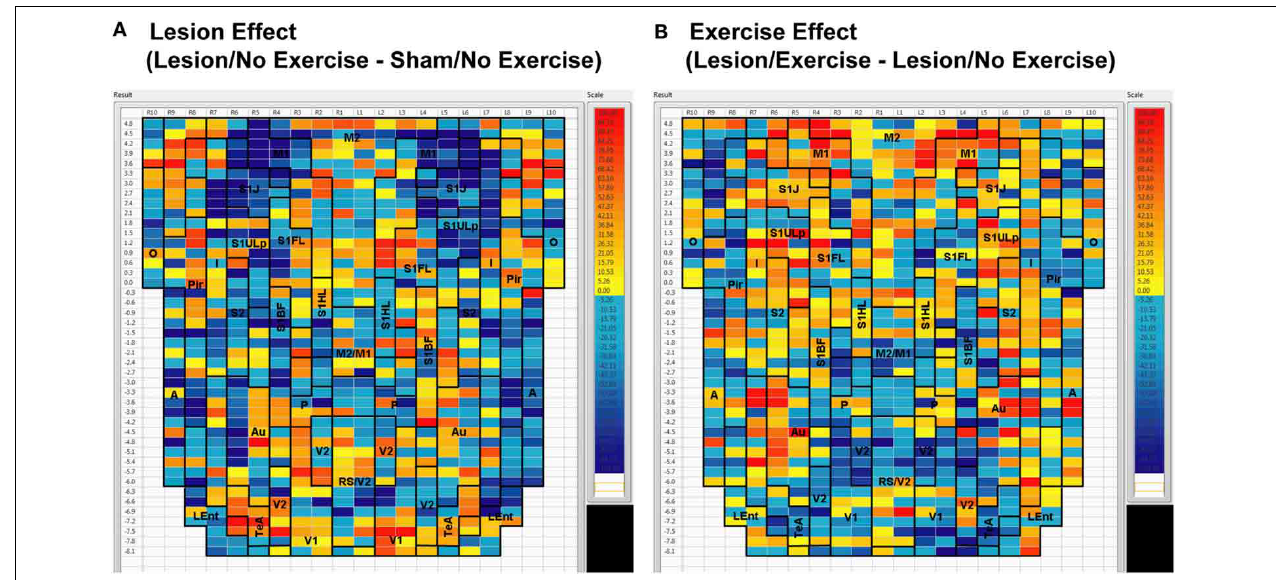
FIGURE 3 | Between-group differences in functional connectivity degree. Differences in cortico-cortical functional connectivity degree between (A) animals with bilateral striatal lesions and sham animals (Lesion/No